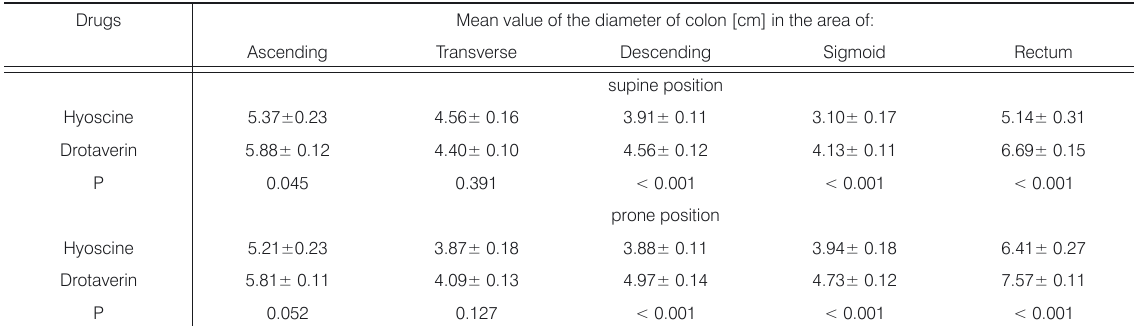
Table 5. Influence of hyoscine and drotaverine on the degree of distension of the colon at identical intracolonic pressure (15 mmHg) in the supine and prone positions. The comparisons were made between the mean values of the diameter of colon in identical areas from the ascending colon, transverse colon, descending colon, sigmoid colon, and rectum for both groups of patients.